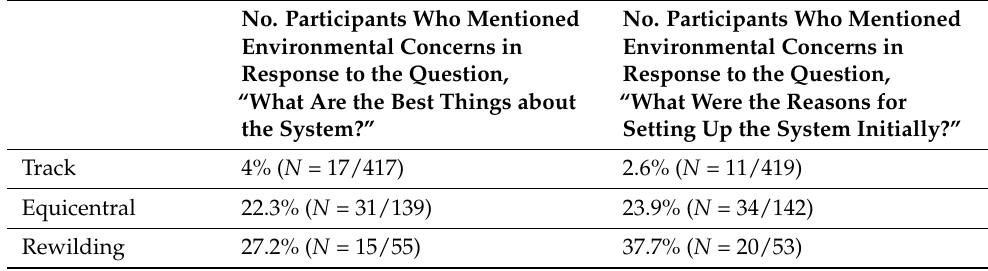
Table 3. Number of respondents of each system, who mentioned environmental concerns (for example, soil health, biodiversity, or wildlife) in response to two free-text